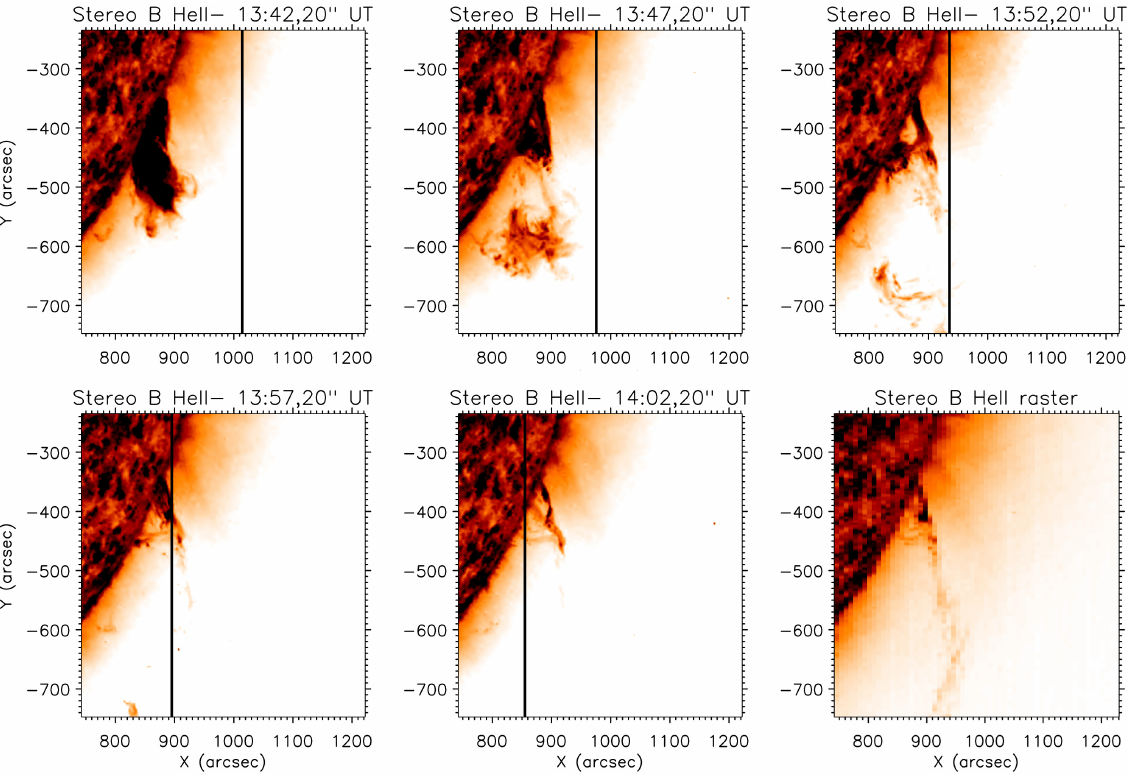
Fig. 4. Sequence of STEREO-B EUVI He II λ 304 images showing the evolution of chromospheric material in the HINODE/EIS field of view (yellow box in Fig. 3) during the ∼ 1 h raster acquired from 13:15 to 14:18UT. The vertical black line shows the instantaneous position of the EIS slit during the West-East scanning. The bottom right panel shows the simulated raster resulting from STEREO/EUVI data to be compared directly with EIS line intensity maps (see Fig.